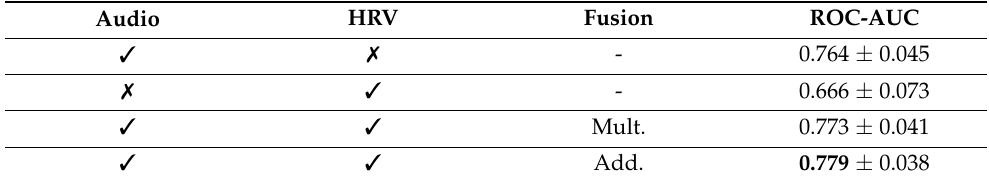
Table 17. Average ROC-AUC scores for the discrimination between stable and anomalous (pre- relapsing or relapsing) patients’ condition, depending on the modalities and fusion.